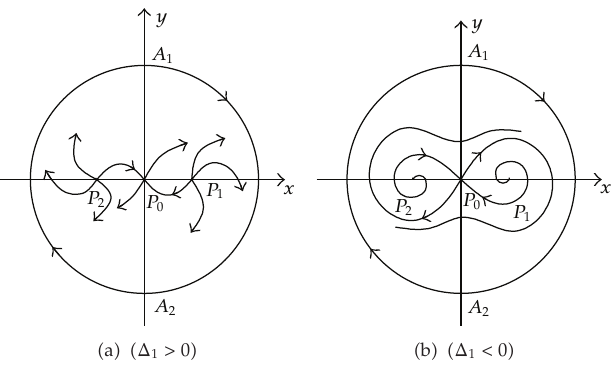
Figure 7: (cid:6) b > 0, c > 0 (cid:7)